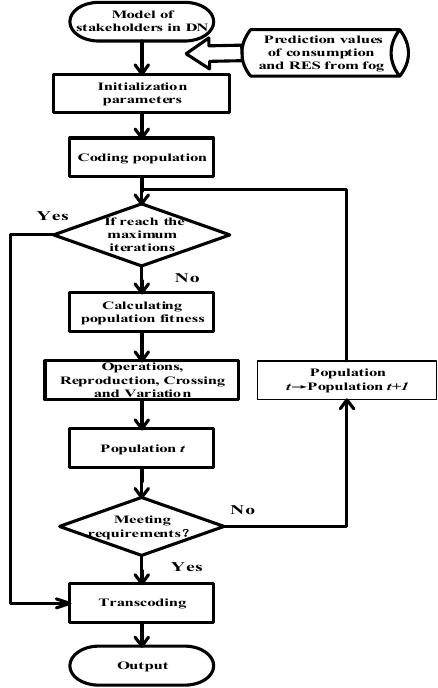
Figure 4. Diagram of decision-making optimization with the genetic algorithm Figure 4 . Diagram of decision-making optimization with the genetic algorithm (GA).